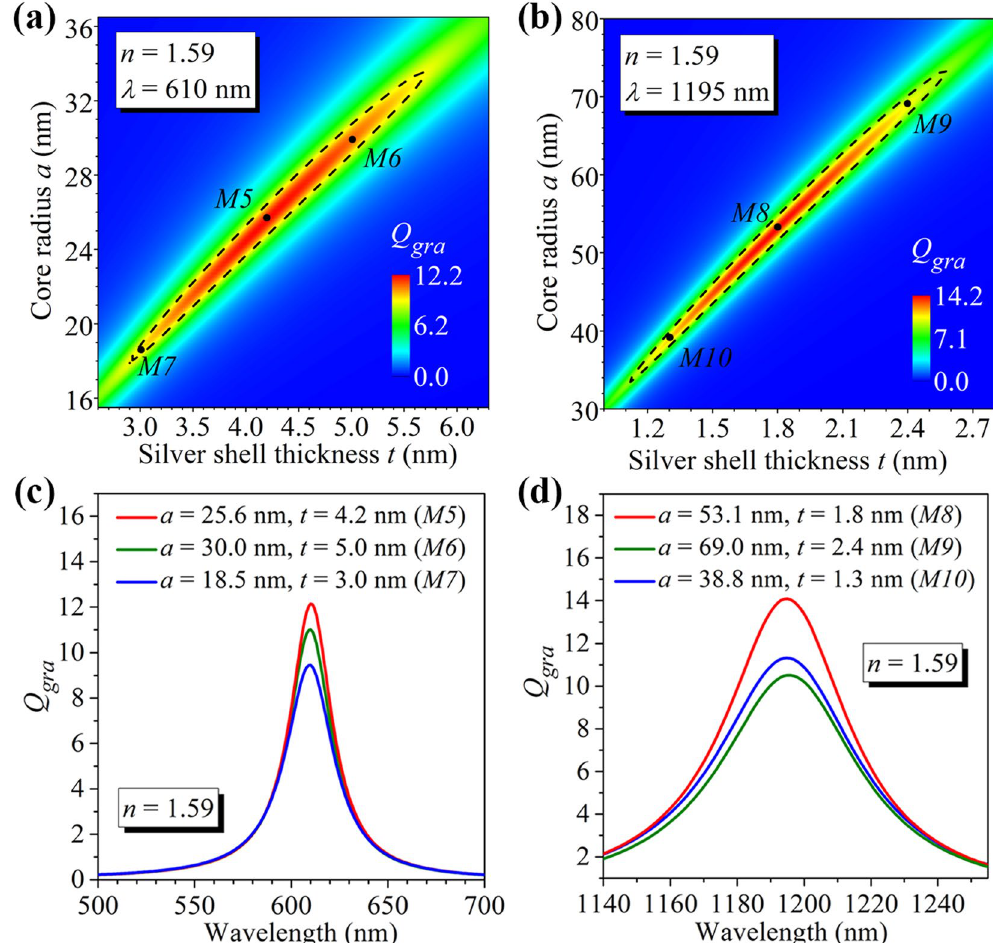
Figure 4. Graphene absorption efficiency as a function of core radius and silver shell thickness calculated at the given wavelength of λ = 610 nm ( a ) and the given wavelength of λ = 1195 nm ( b ) for the graphene-wrapped DMCSRs with fixed core refractive index of n = 1.59. Black dashed lines in ( a ) and ( b ) outline the boundary where the absorption efficiency is equal to 9. Marked points M5, M6, and M7 in ( a ) and M8, M9, and M10 in ( b ) locate inside the outlined regions. ( c ) Absorption efficiency spectra of the graphene-wrapped DMCSRs with parameters corresponding to the marked points M5, M6, and M7 in ( a ). ( d ) Absorption efficiency spectra of the graphene-wrapped DMCSRs with parameters corresponding to the marked points M8, M9, and M10 in ( b